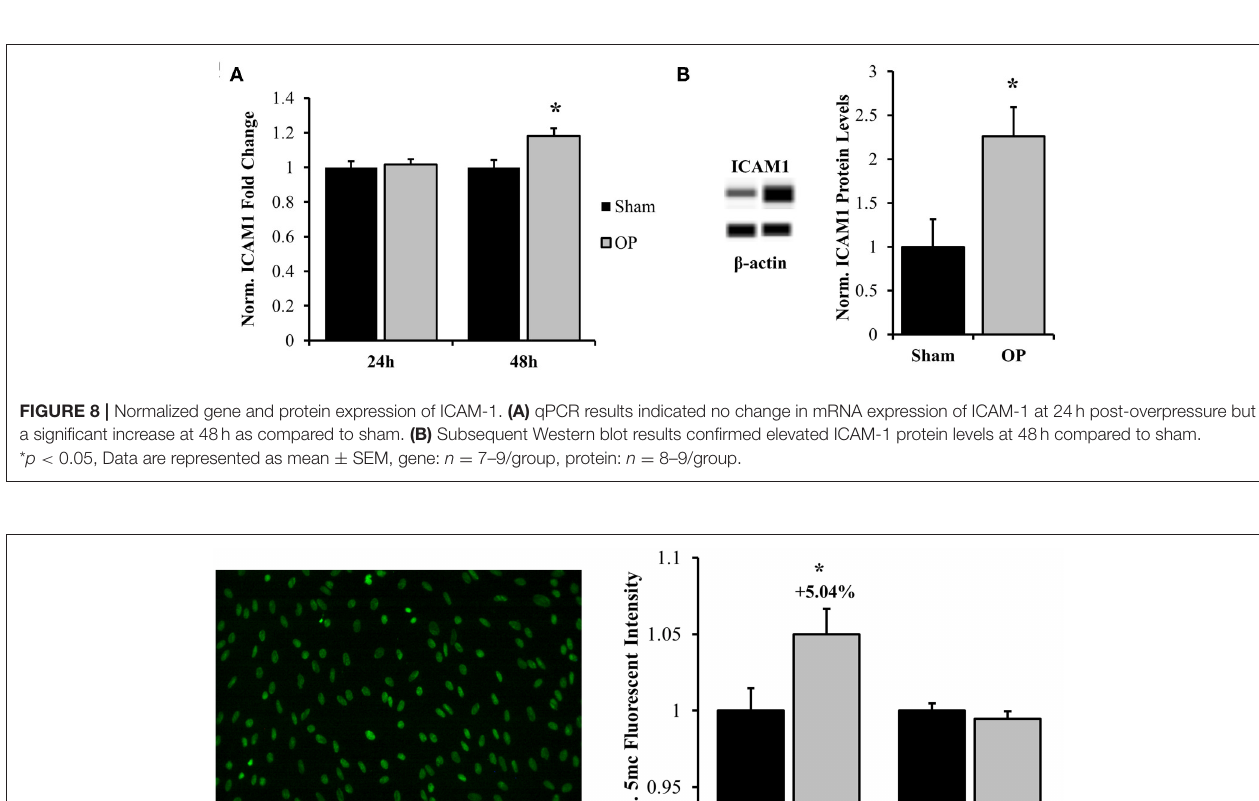
FIGURE 7 | EMSA results for binding efficiency of nuclear proteins to ICAM-1 promoter sequence. (A) Assay optimization was conducted for specificity of protein binding to the NF- κ B binding sequence of interest. The same sample was incubated with and without unlabeled DNA sequence to ensure competitive binding. The first lane contains both labeled and unlabeled DNA while the second contains only labeled. (B) Representative DNA: protein shifts for sham and overpressure groups are shown. Quantification of bound to free DNA determined that overpressure induced a significantly higher association of nuclear proteins with the NF- κ B binding site on the ICAM-1 promoter. * p < 0.05, Data are represented as mean ± SEM, n = 6–8/group.